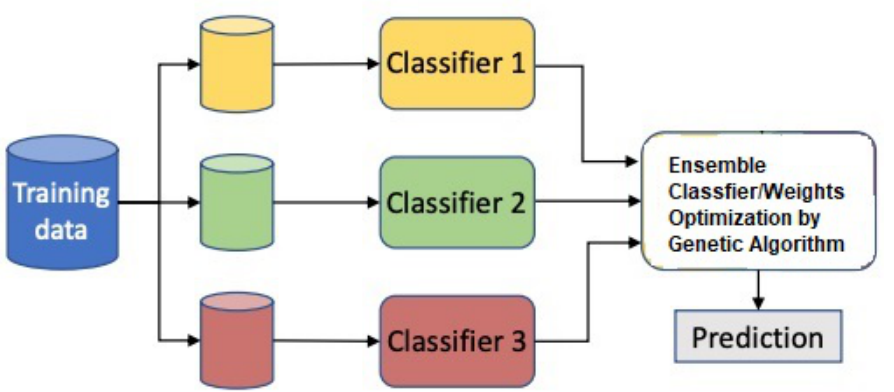
Figure 7. Block diagram of ensemble